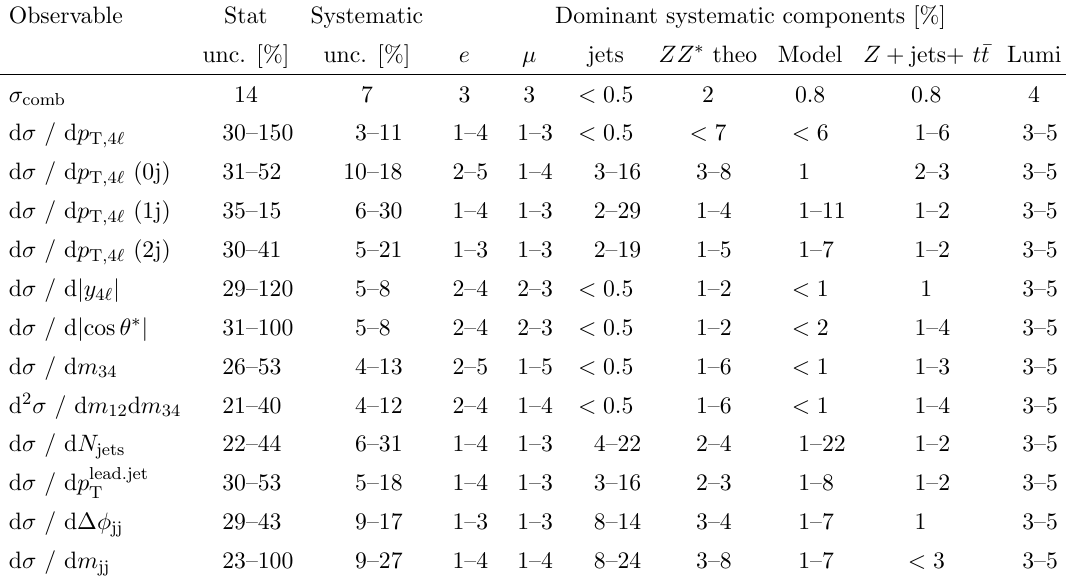
Table 3. Fractional uncertainties for the inclusive (cid:12)ducial cross section (cid:27) comb , obtained by com- bining all decay channels, and ranges of systematic uncertainties for the di(cid:11)erential observables. The columns e , (cid:22) , jets represent the experimental uncertainties in lepton and jet reconstruction and identi(cid:12)cation. The ZZ (cid:3) theory uncertainties include the PDF and scale variations. The model uncertainties are dominated by the production mode composition variations in the extraction of the correction